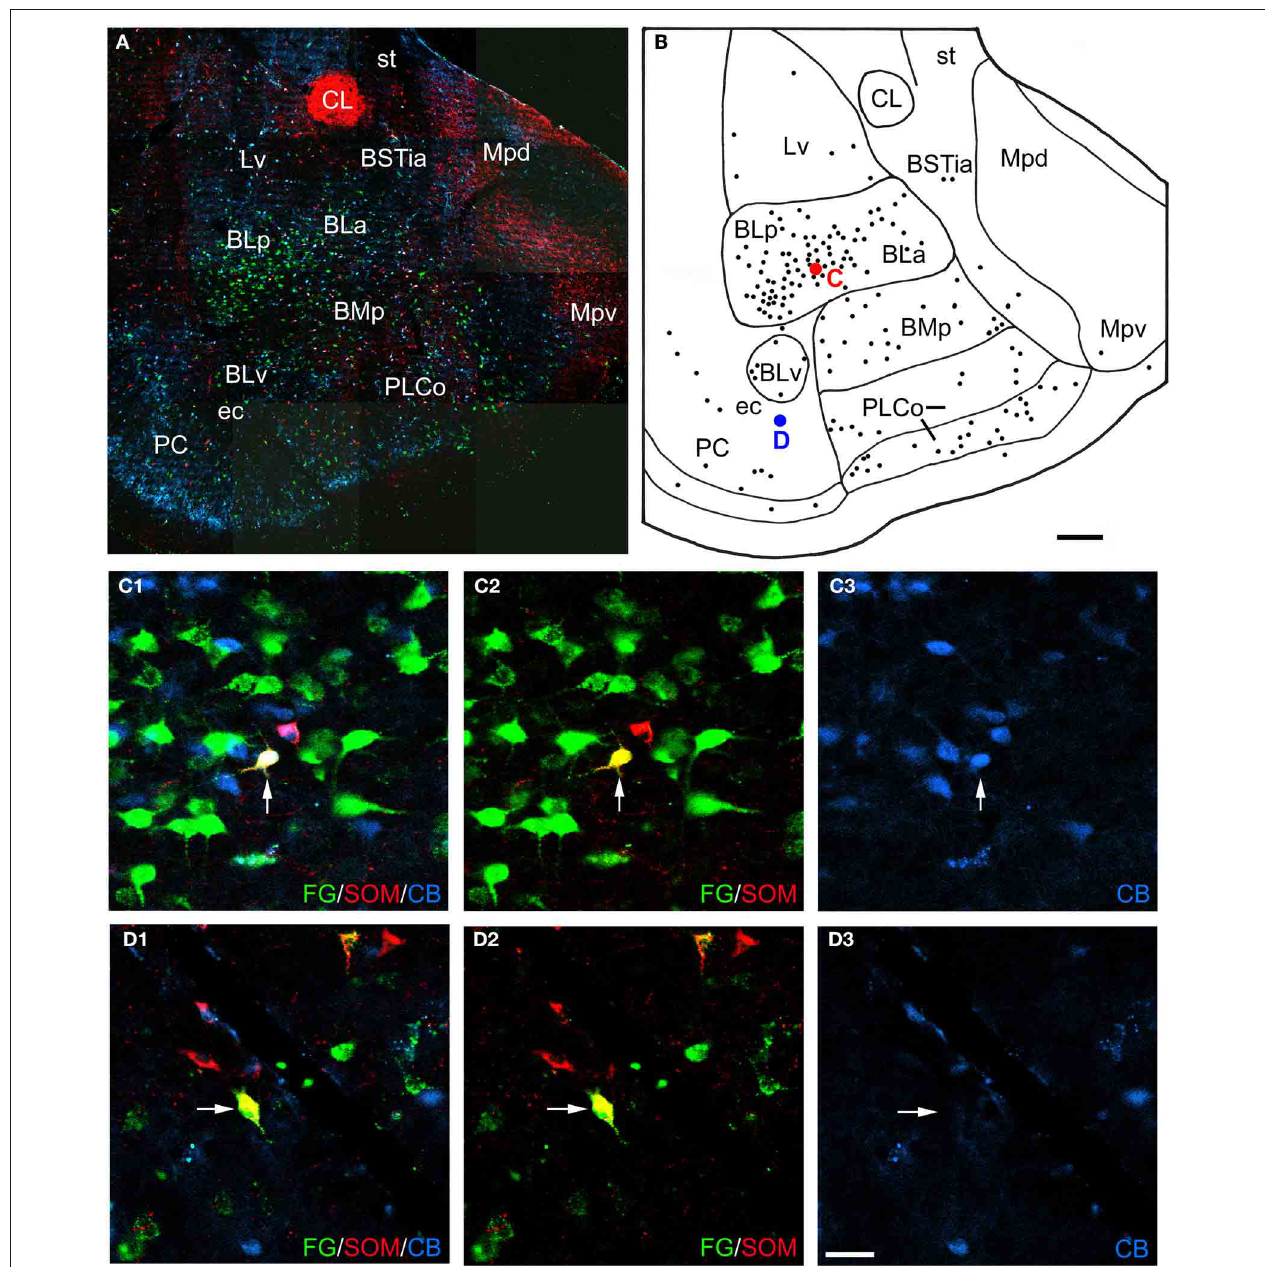
FIGURE 3 | (A) Low power photomontage of a coronal section through the middle of the amygdala (Bregma − 3.3) in case R7 that was triple-labeled for FG (green), SOM (red), and CB (blue). Lateral is left. After this section was analyzed the coverslip was removed and the section was counterstained with pyronin Y. This allowed the nuclear borders to be more precisely defined, as depicted in B . (B) Drawing of the distribution of FG-labeled neurons seen in A , created by overlaying a plot of FG-labeled neurons in this section over a drawing of the nuclei identified after counterstaining. The positions of a triple-labeled FG/SOM/CB + neuron in the basolateral nucleus (red dot), and a FG/SOM + neuron in the external capsule (ec) that was CB-negative (blue dot) are indicated. (C1–C3) Photomicrographs of the FG/SOM/CB + neuron shown in red in B (arrow). (C1) Merged image visualizing all three channels. (C2) Image with the blue channel omitted, showing that the neuron exhibited colocalization of FG and SOM (yellow). (C3) Image with only the blue